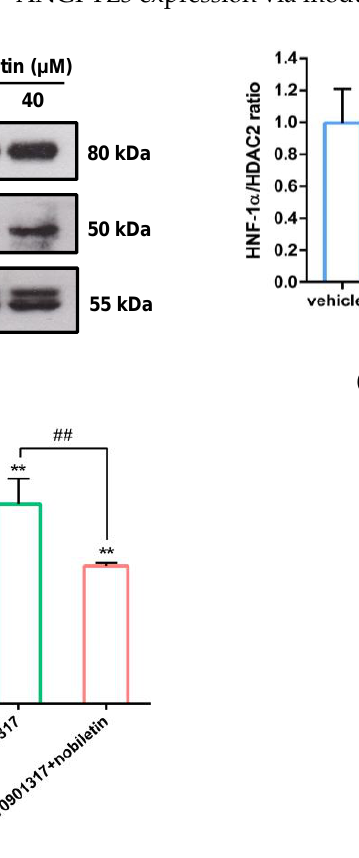
Figure 5. Effects of nobiletin on HFN-1 α and LXR α protein expression and LXR α activity. HepG2 cells were treated with vehicle or nobiletin (20 and 40 µ M) for 24 h. ( a ) The nuclear HFN-1 α , LXR α and HDAC2 protein levels were detected by Western blot analysis. The normalized intensity of ( b ) HFN-1 α and ( c ) LXR α versus HDAC2 is presented as the mean ± SD from three independent experiments. ( d ) HepG2 cells were cotransfected with a pGL3-ANGPTL3 p( − 250/+20)) plasmid and a Renilla control plasmid for 24 h. The plasmid-transfected cells were pretreated with vehicle or nobiletin (40 µ M) for 1 h followed by incubation with the LXR α agonist T0901317 (1 µ M) for an additional 24 h. The luciferase activities were measured with a reporter assay kit and normalized to the respective Renilla luciferase activities. The data represent the mean ± SD from three independent experiments. ( e ) HepG2 cells were pretreated with vehicle or nobiletin (40 µ M) for 1 h followed by treatment with T0901317 (1 µ M) for an additional 24 h. ANGPTL3 mRNA was detected via RT–qPCR. Data are shown as the mean ± SD of three independent experiments. ** p < 0.01 indicates a significant difference compared to the vehicle-treated group. ## p < 0.01 indicates a significant difference compared to the group treated only with